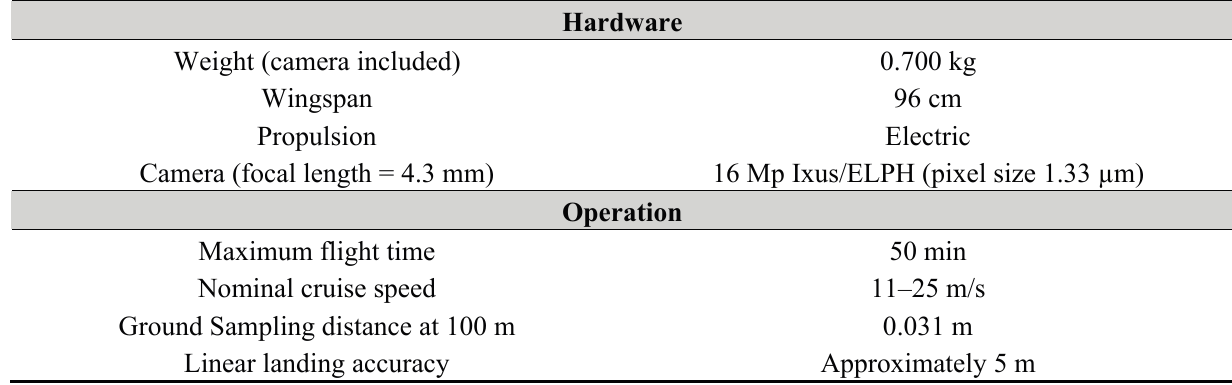
Table 2. Main technical features of the employed fixed-wing RPAS.